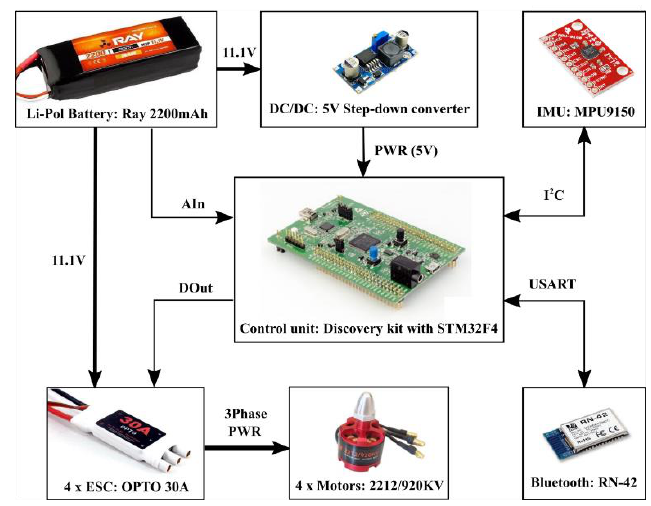
Figure 7. Scheme of all peripherals connected to the control board (PWR—power, IMU—Inertial Measurement Unit, ESC—Electronic Speed Controller, USART—Universal Synchronous/Asynchronous Receiver and Transmitter, AIn—Analogue Input, DOut—Digital Output).